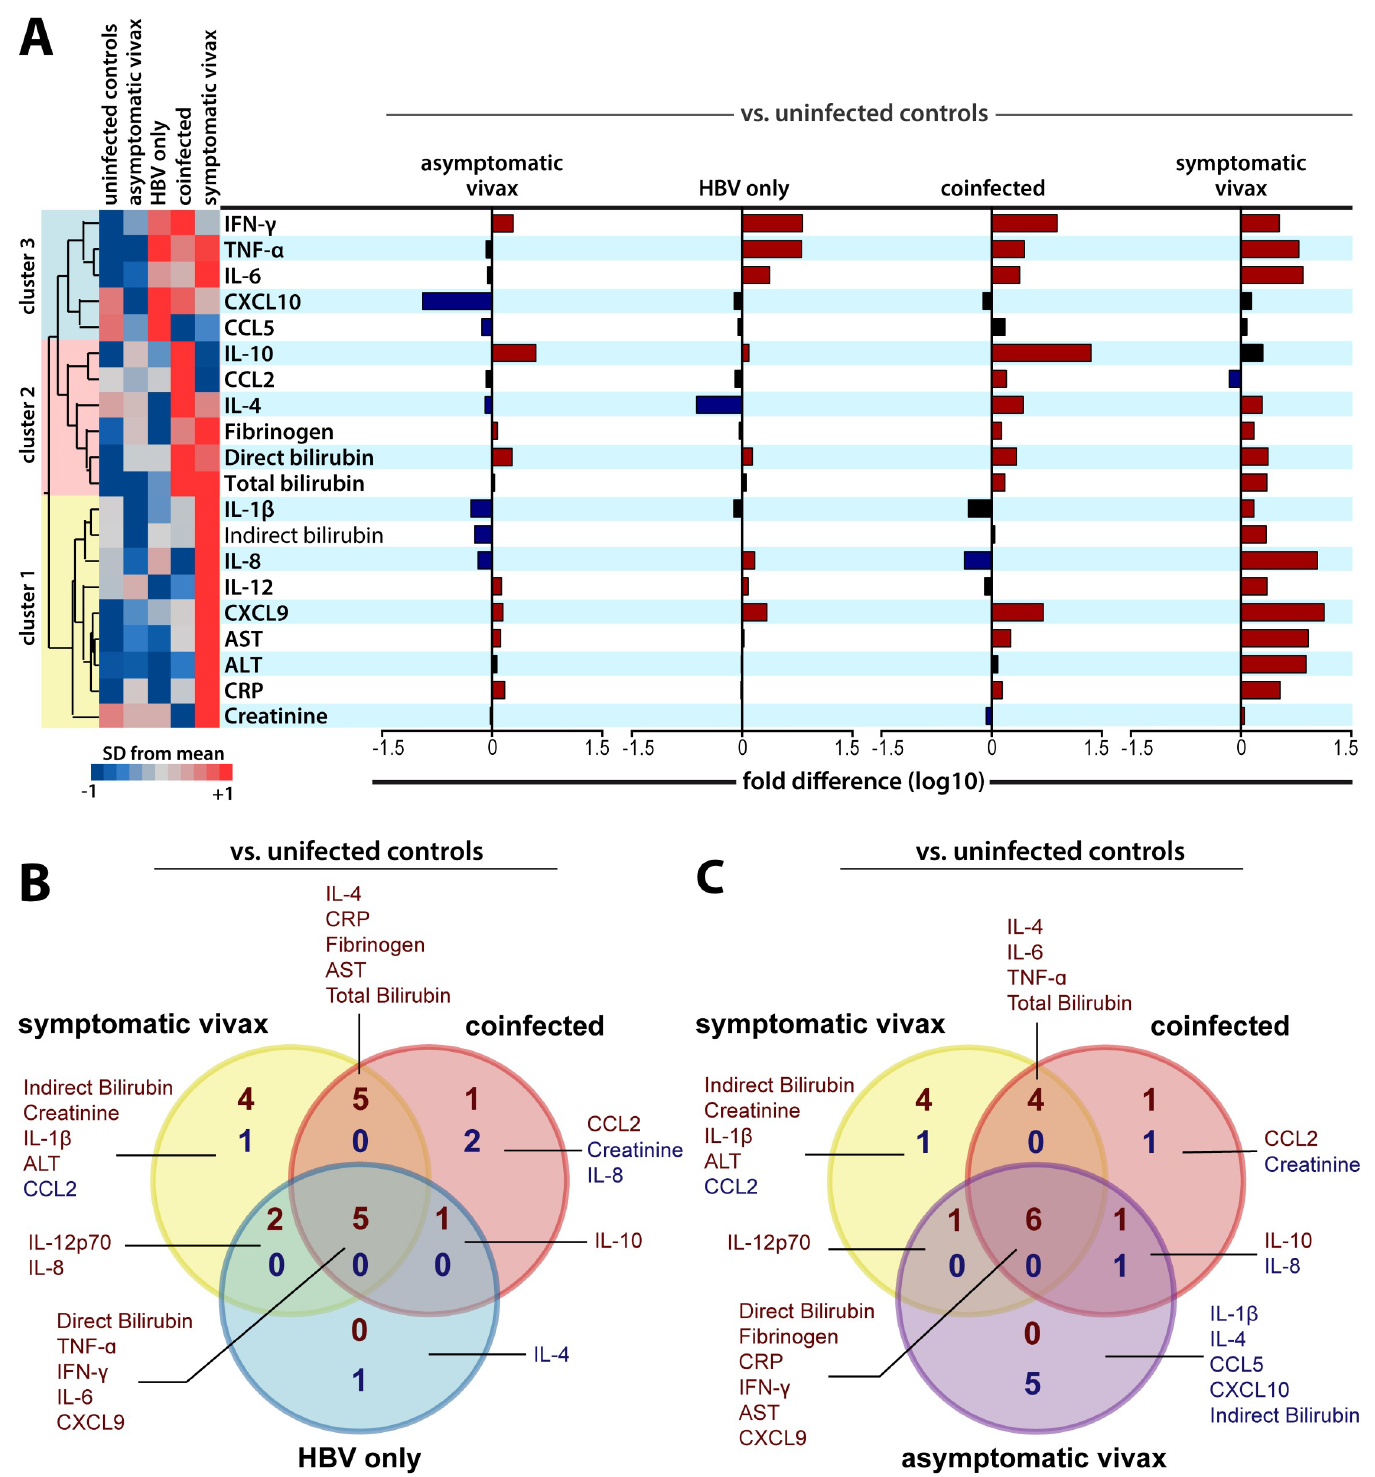
Fig 1. Inflammatory profile and biochemical-based distribution of HBV and P . vivax patients. ( A ) Overall profile of plasma concentrations of the biochemical parameters in uninfected controls (n = 165), asymptomatic vivax malaria subjects (n = 127), symptomatic vivax malaria patients (n = 141), HBV patients (n = 29) and P . vivax -HBV coinfected patients (n = 28). Data were processed using hierarchical cluster analysis (Ward’s method) with 100x bootstrap. Dendrograms represent hierarchical distance. The three identifiable clusters are presented and colored. Histograms represent differences of variables for each disease group alone compared to